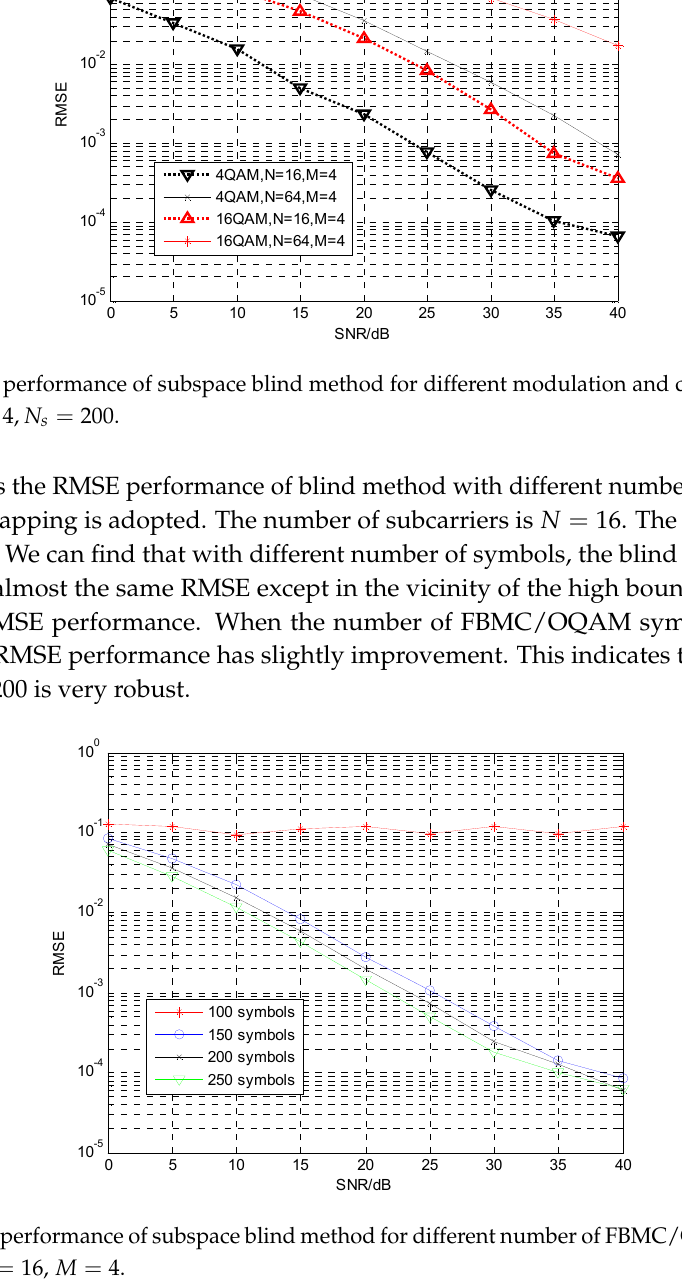
Figure 7. RMSE performance of subspace blind method for different number of FBMC/OQAM symbols, with 4QAM, N = 16, M =